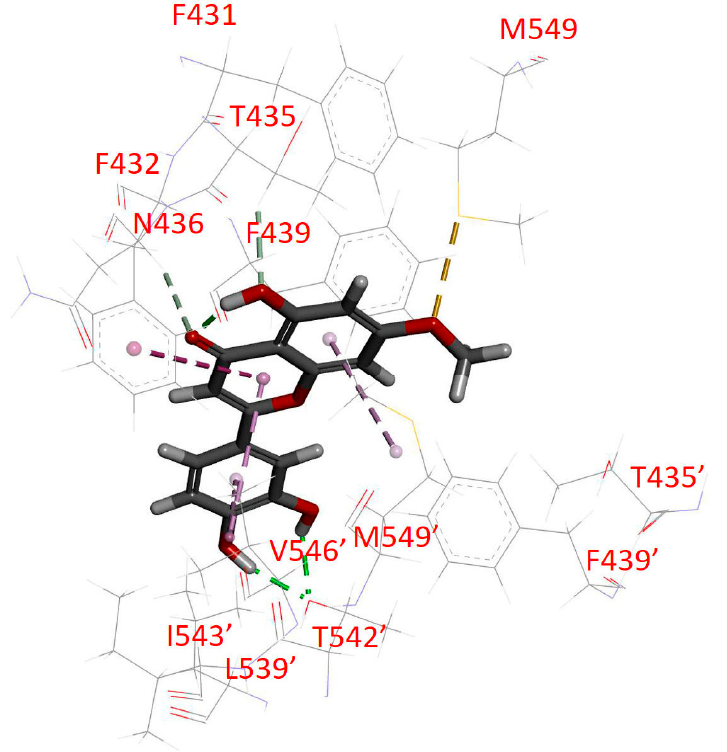
Figure 7. Docking of hydroxygenkwanin to ABCG2. The lowest energy binding mode of hydroxygenkwanin with the ABCG2 protein structure (PDB:6VXH) was predicted by using Accelrys Discovery Studio 4.0 software (Dassault Systemes BIOVIA, San Diego, CA, USA), as described in the Section 4. Materials and Methods section. The stick representation (yellow) shows the molecular model of hydroxygenkwanin, and the predicted interacting amino acid atoms are represented by the following colors: carbon is colored gray; hydrogen is colored light gray; oxygen is colored red; and fluorine is colored cyan. Dotted lines represent the proposed interactions. The residues of monomer 2 are indicated by prime symbols.